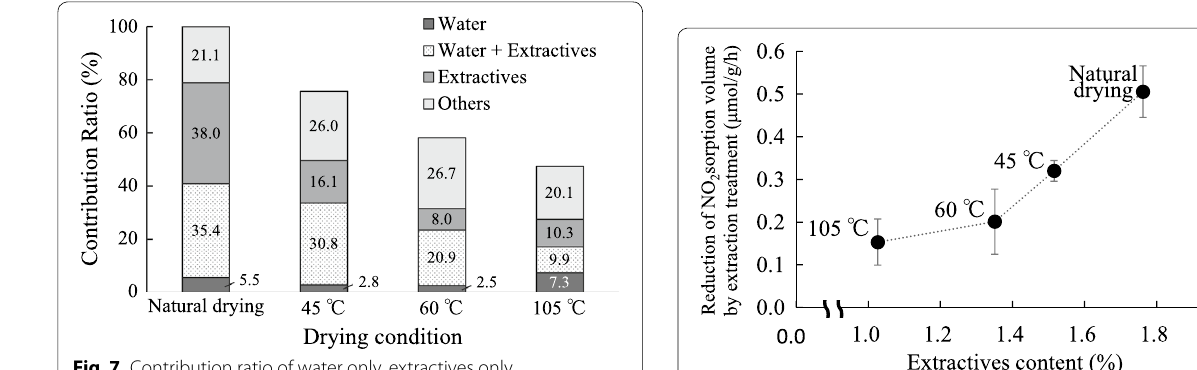
Fig. 7 Contribution ratio of water only, extractives only, water extractives, and others in NO 2 sorption under different drying + conditions. The ratio for each kiln-drying condition shows the ratio of its value to the value under the natural drying condition